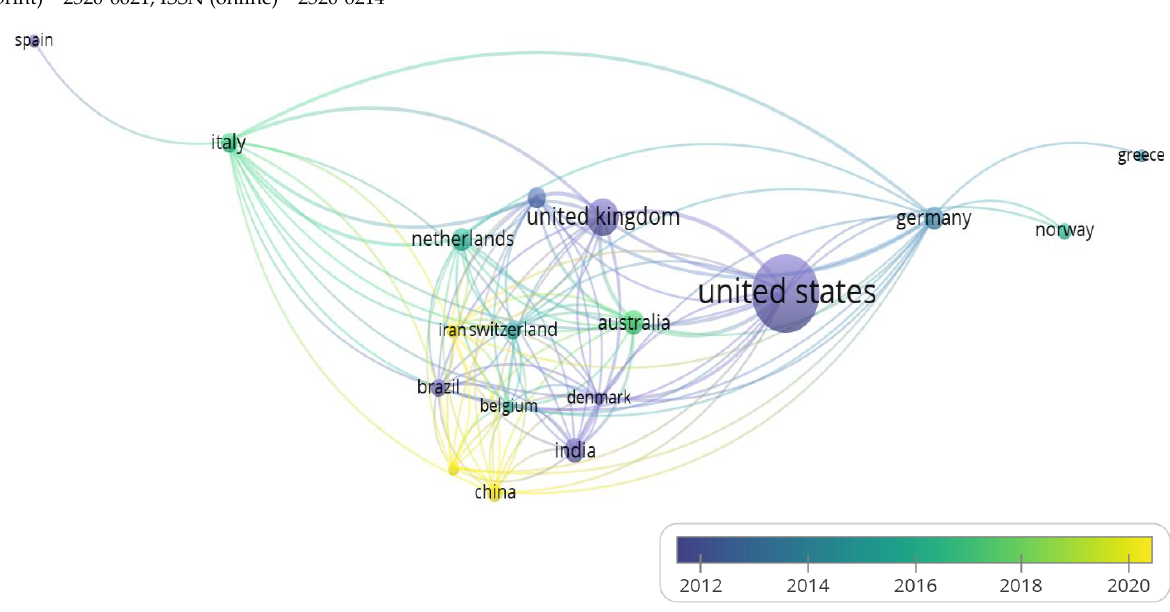
Figure 4. Visualization of an extensive geographic map of the spatiotemporal dimension of research on the behavioral and social dimension of the public health system for 2012-2020 using the VOSViewerv software toolkit. 1.6.15 in papers from the Scopus database Sources: developed/compiled/systematized by the authors based on the Scopus database using the VOSViewerv software toolkit.1.6.15 (Dotsenko,